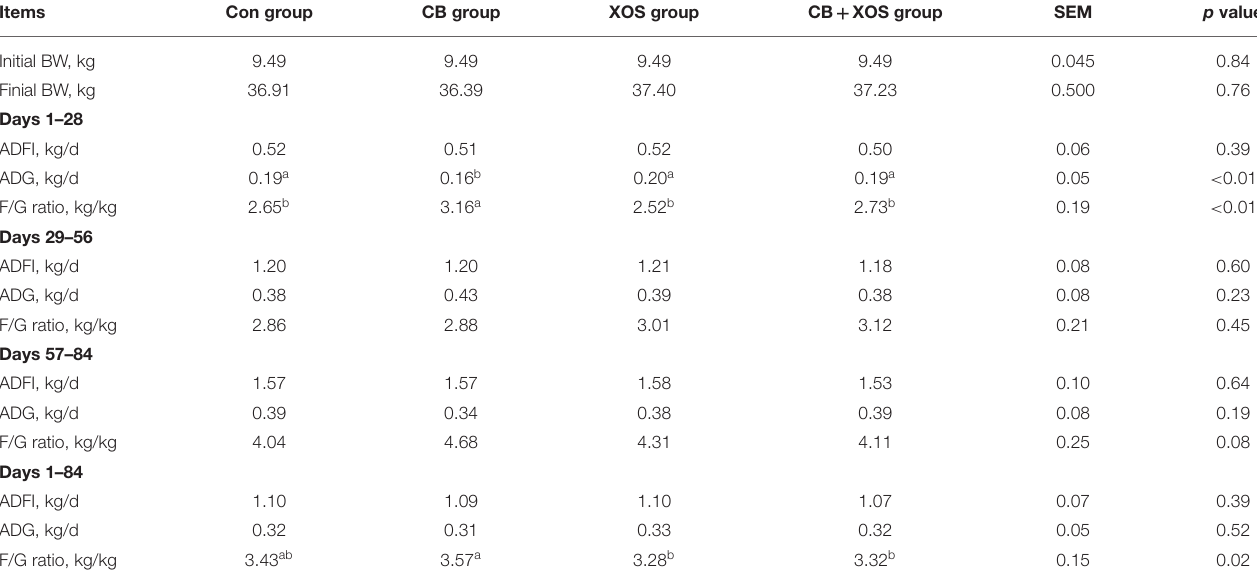
TABLE 2 | Effects of dietary addition with Clostridium butyricum (CB) and xylo-oligosaccharides (XOS) on growth performance of Huanjiang mini-pigs.